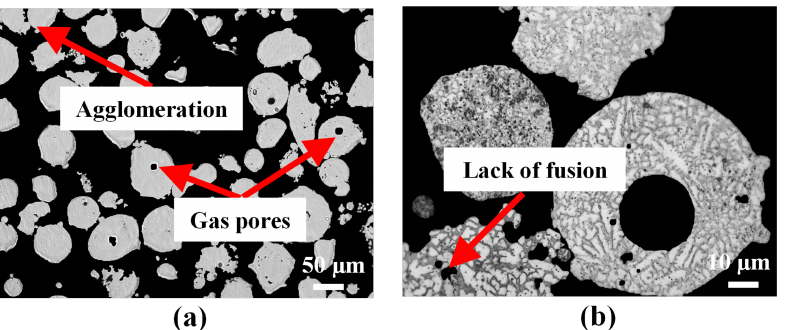
Figure 5. ( a ) Cross-sectional OM image of the used IN718 powder revealing the pores. ( b ) Cross- sectional OM image of the etched powder highlighting the